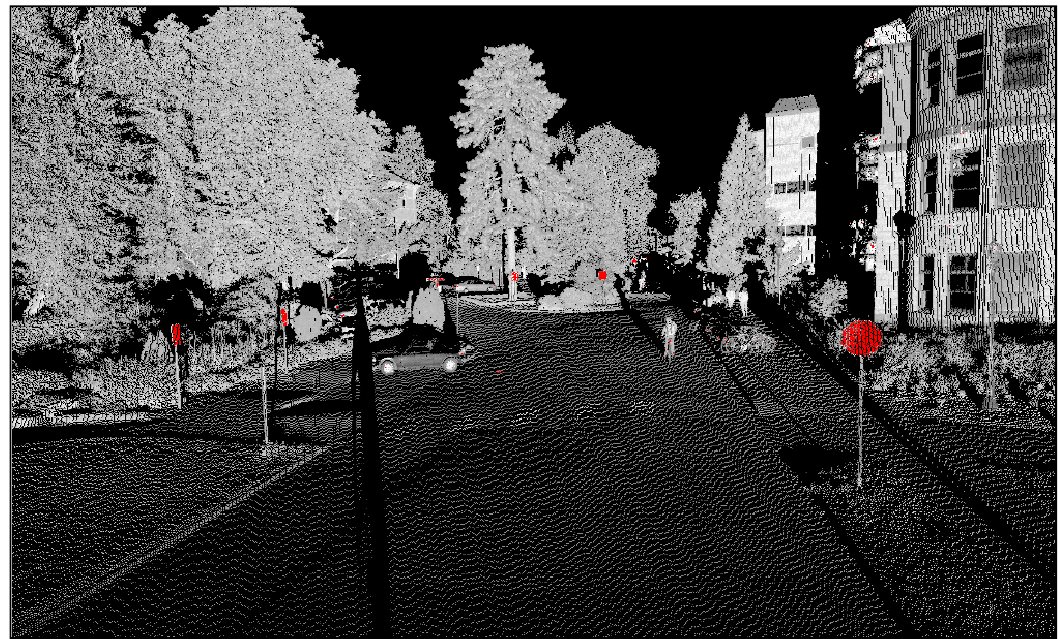
Figure 16. Reflective signs (red) extracted from a static TLS point cloud at the Oregon State University